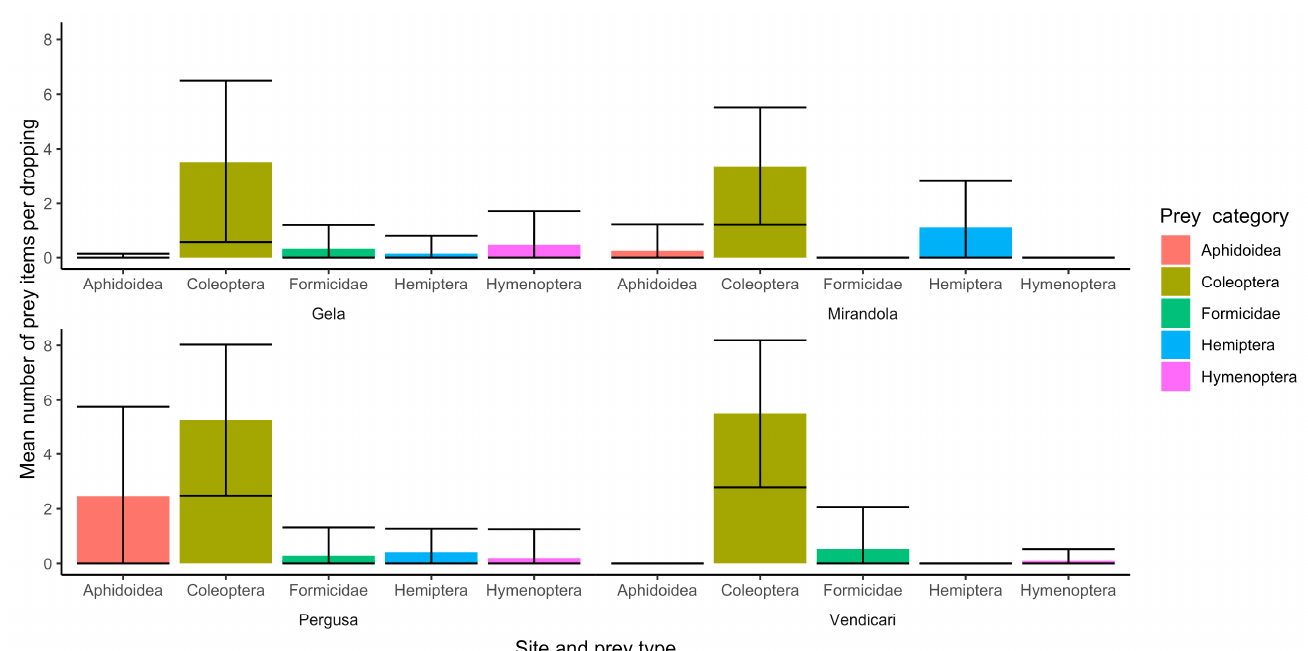
Figure 3. Mean number ( ± standard deviation) of prey items found in the droppings of Reed Warblers in the four Italian study areas.